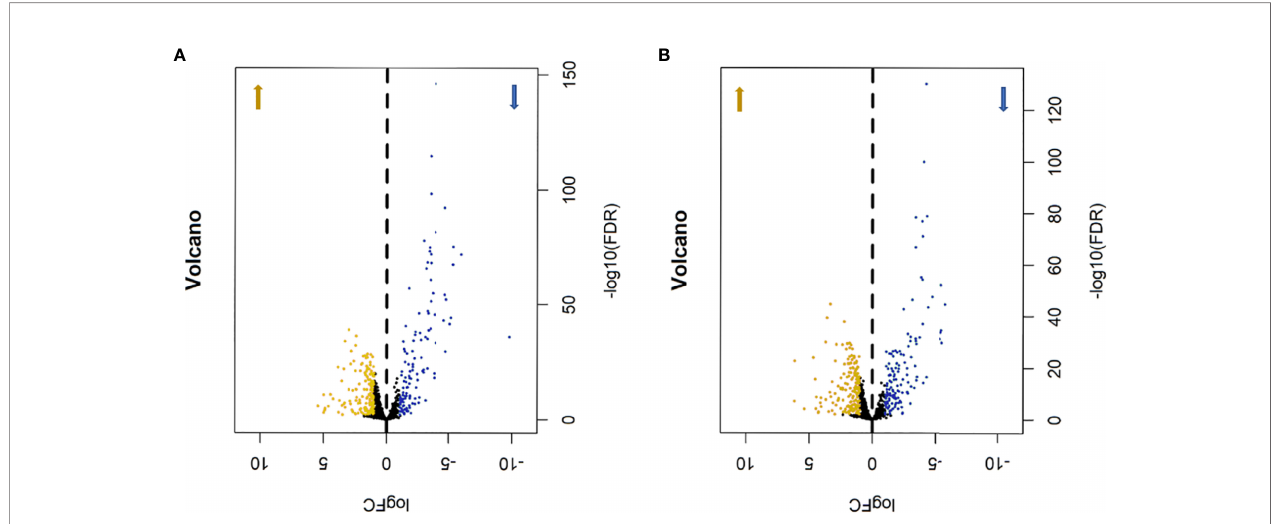
FIGURE 1 | The volcano map of differentially expressed metabolism-related genes, Khaki represents up-regulated metabolic genes, blue represents down-regulated metabolic genes. (A) HER2-positive breast cancer, 154 up-regulated genes and 121 down-regulated genes. (B) triple-negative breast cancer, 181 up-regulated genes and 139 down-regulated